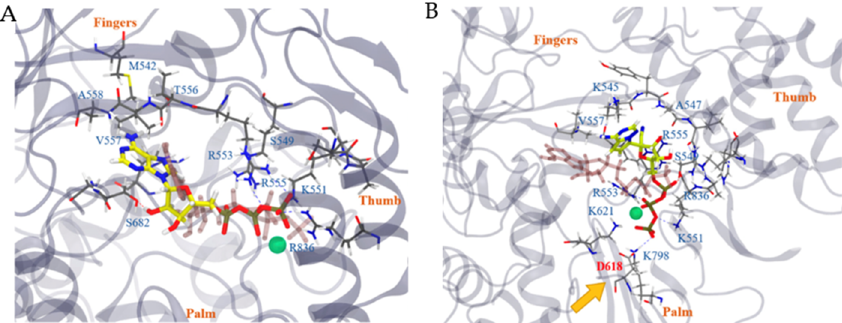
Figure 11. ( A ) The binding interaction of ATP with COVID-19 NSP12. ( B ) The binding interaction of RemTP with COVID-19 NSP12. The green sphere represents the Mg 2+ ion [44].